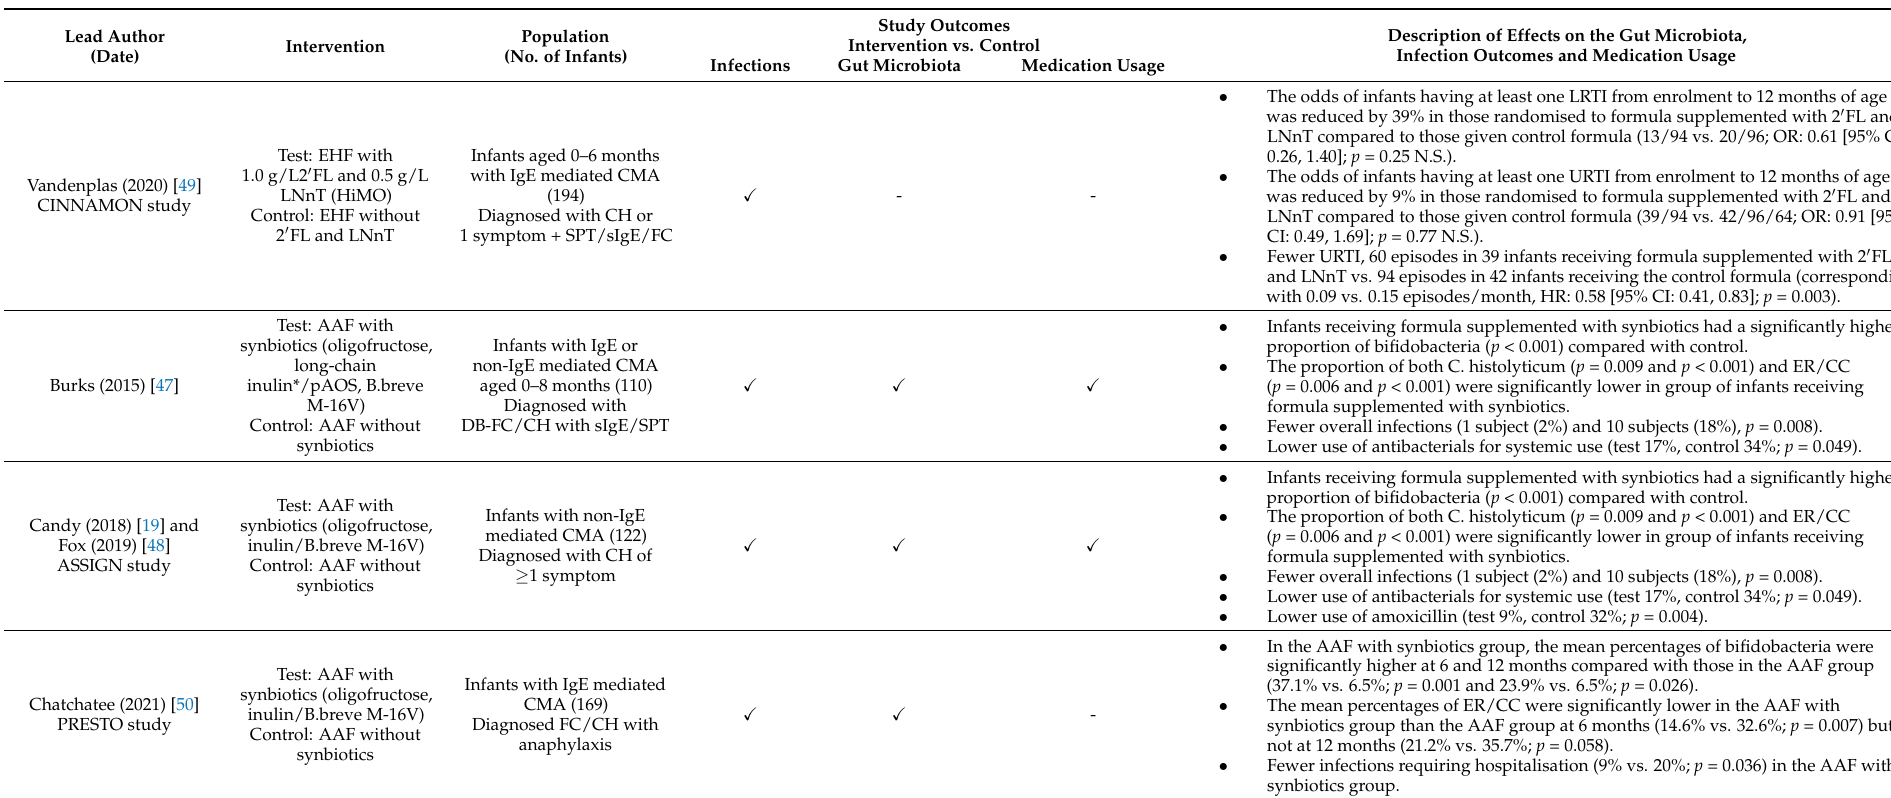
Table 1. Overview of the effects of prebiotics, HiMOs and synbiotics on the gut microbiota, infection outcomes and medication usage in infants with CMA.